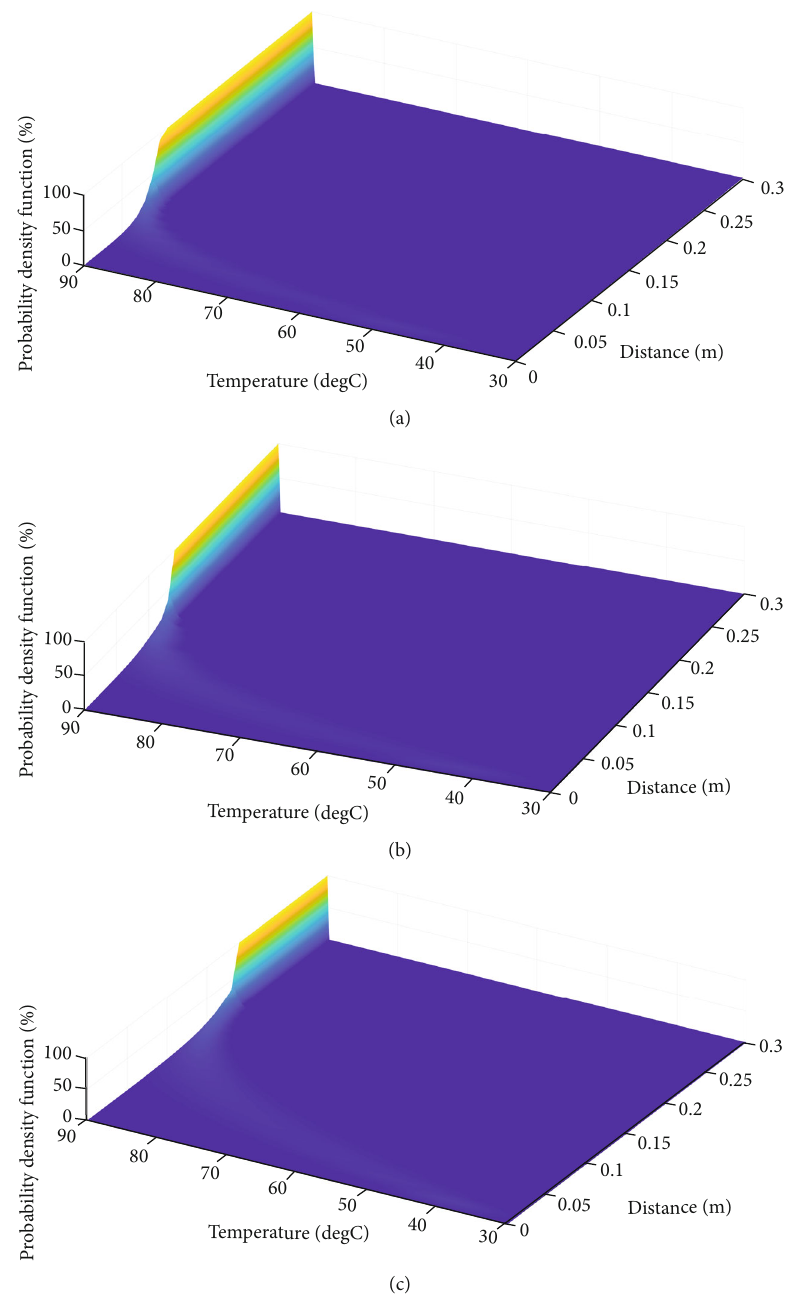
Figure 12: Probability density functions for temperature at times (a) t = 15 (min), (b) t = 30 (min), and (c) t = 60